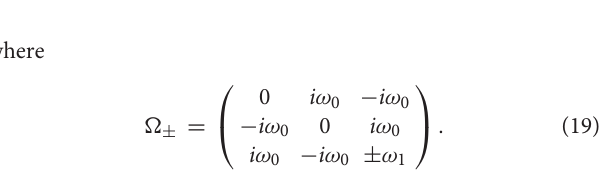
as functions of ω 0 for ω 1 +